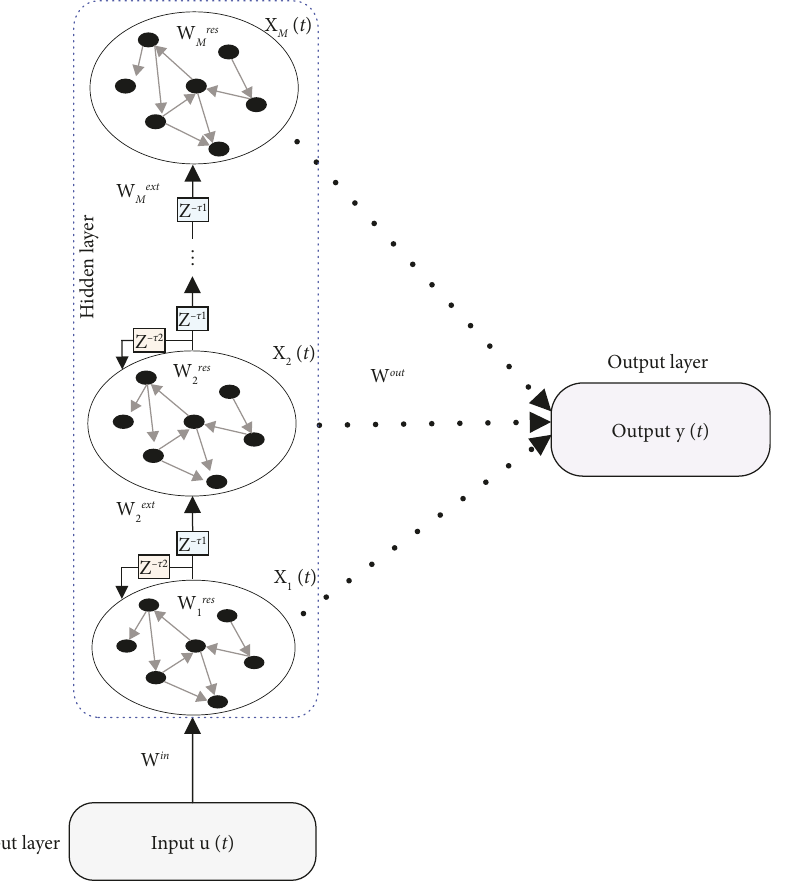
Figure 1: Structure of